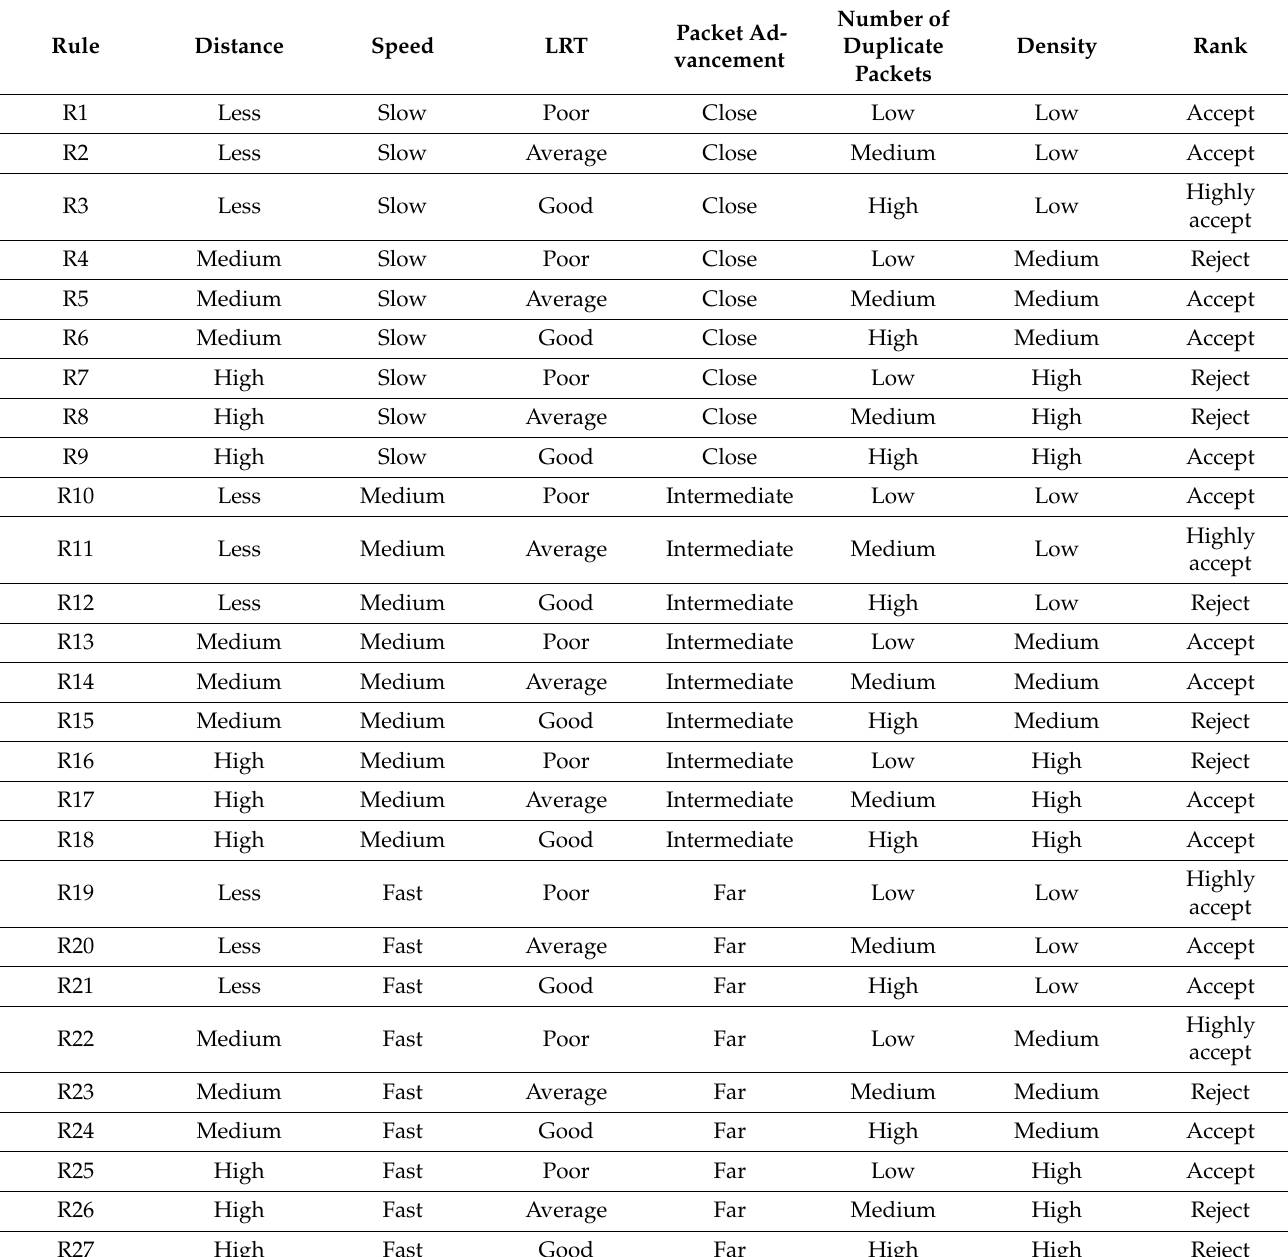
Table 3. Fuzzy logic